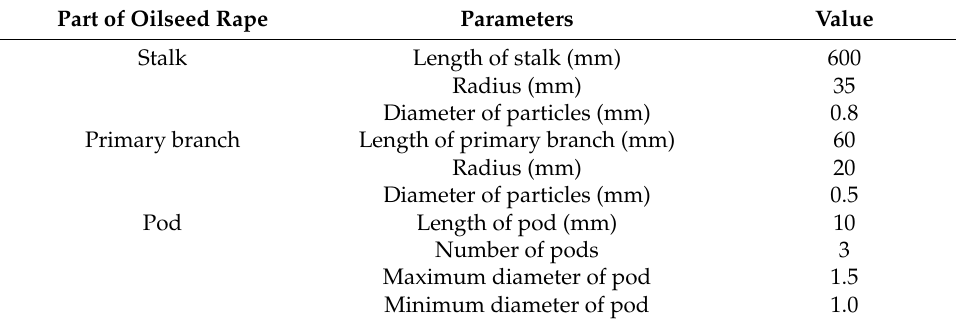
Table 3. Characteristics parameters of oilseed rape